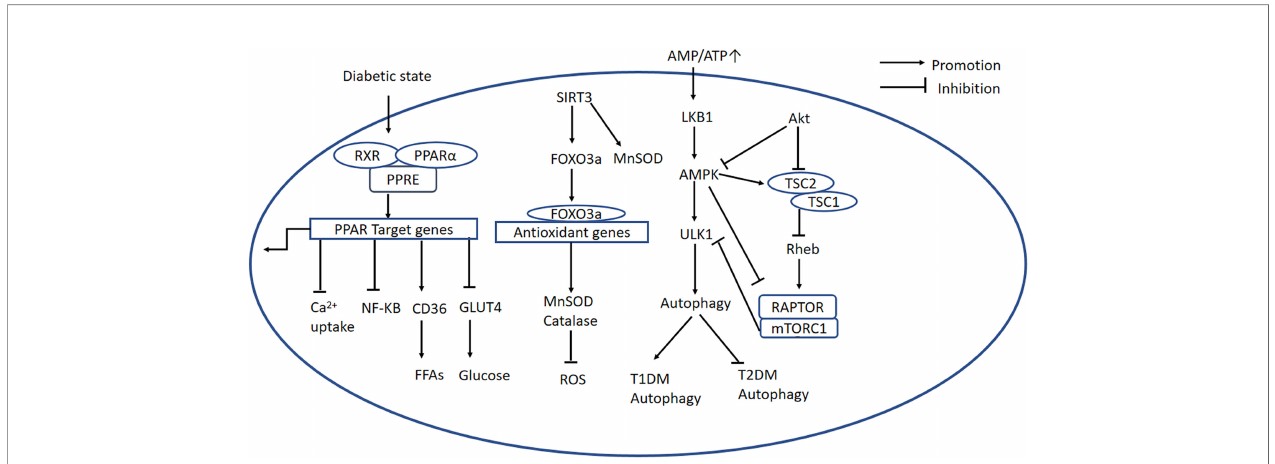
FIGURE 3 | PPAR a -related, AMPK/mTOR, and SIRT3/FOXO3a signaling pathways. PPAR a -related signaling pathway: The PPAR a complex is activated in the diabetic state. PPAR a binds to PPREs with its heterodimeric partner RXR, regulating the expression of target genes. This upregulates CD36, inhibits GLUT4 translocation, inhibits the NF- k B signaling pathway, and inhibits Ca 2+ uptake. AMPK/mTOR signaling pathway: In the diabetic heart, mitochondrial dysfunction causes a low AMP/ATP ratio, activation of LKB1, and consequent activation of AMPK. AMPK suppresses mTORC1 activation via two pathways. Firstly, AMPK directly phosphorylates and inhibits Raptor; secondly, it activates TSC2, and TSC2 forms a complex with TSC1, which inhibits the activity of Rheb, thereby blocking mTORC1 activation. PI3K/AKT signaling is important in mTORC1 activation because it recruits Rheb and inhibits autophagy by inhibiting AMPK. In addition, ULK1 is another regulator in autophagy, and mTOR inhibits ULK1 activation and autophagy. SIRT3/FOXO3a signaling pathway: SIRT3 regulates autophagy through several mechanisms. First, SIRT3 deacetylates MnSOD. Second, SIRT3 expression is high during cardiomyocyte stress, leading to the deacetylation of FOXO3a, which is translocated to the nucleus where it initiates the transcription of FOXO-dependent antioxidant genes SOD and catalase . PPAR a , peroxisome proliferator-activated receptor alpha; PPREs, peroxisome proliferator response elements; RXR, retinoid X receptor; CD36, cluster of differentiation 36; GLUT4, glucose transporter 4; ATP, adenosine triphosphate; AMP, adenosine monophosphate; LKB1, liver kinase B1; AMPK, adenosine monophosphate-activated protein kinase; mTORC1, mechanistic target of rapamycin complex 1; TSC1,2, tuberous sclerosis complex 1,2; Rheb, Ras homolog enriched in brain; Raptor, regulatory-associated protein of mTOR; ULK1, Unc-51-like autophagy-activating kinase 1; PI3K, phosphatidylinositol 3-kinase; PKB/AKT, protein kinase B; SIRT3, Sirtuin 3; FOXO3a, forkhead box O3a; PINK1, PTEN-induced putative kinase protein 1; MFN2, mitofusin